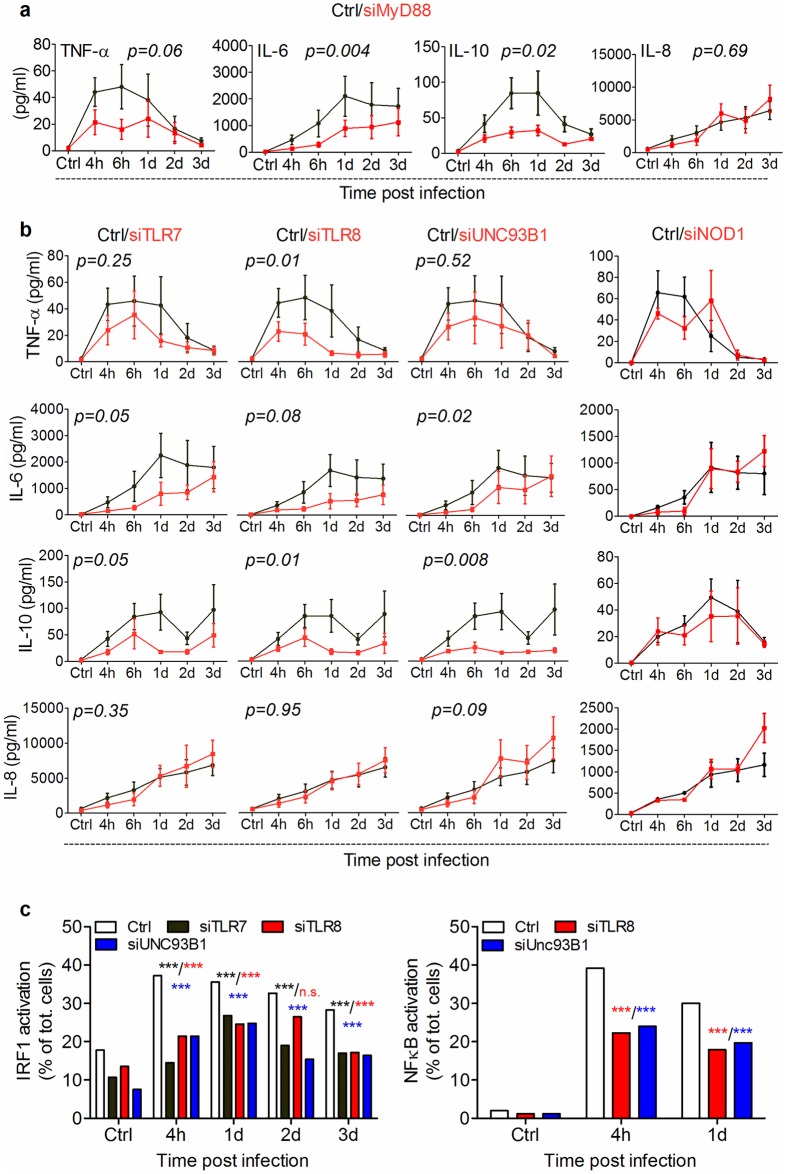
TLR7/8/MyD88 trigger inflammatory signaling induced by Mav infection.Human MDMs were treated with siRNA against target genes or a non-targeted control before infection with Mav-CFP (10 min uptake followed by chase for the indicated times). Cell supernatants were harvested at the indicated time points post infection and secreted cytokines assessed by multiplex ELISA. Cytokine responses from Mav-infected MDMs pretreated with siMyD88 (A), siTLR7, siTLR8, siUNC93B1 or siNOD1 (B). Graphs represent average concentrations +/- SEM of TNF-α, IL-6, IL-10 and IL-8 from at least 6 donors treated with target siRNA (red) or non-targeted siRNA (black). (C) Cells were pre-treated and infected as indicated, fixed and stained for IRF-1 and NF-κB nuclear translocation before analysis using non resolution-limited confocal microscopy. Quantification graphs represent the mean value for each time point (n>700 cells per time point) of one representative donor from three independent experiments. P values between Ctrl and each time point were calculated using Fisher Exact Test (* P <0.05, ** P <0.01 and *** P <0.005.).